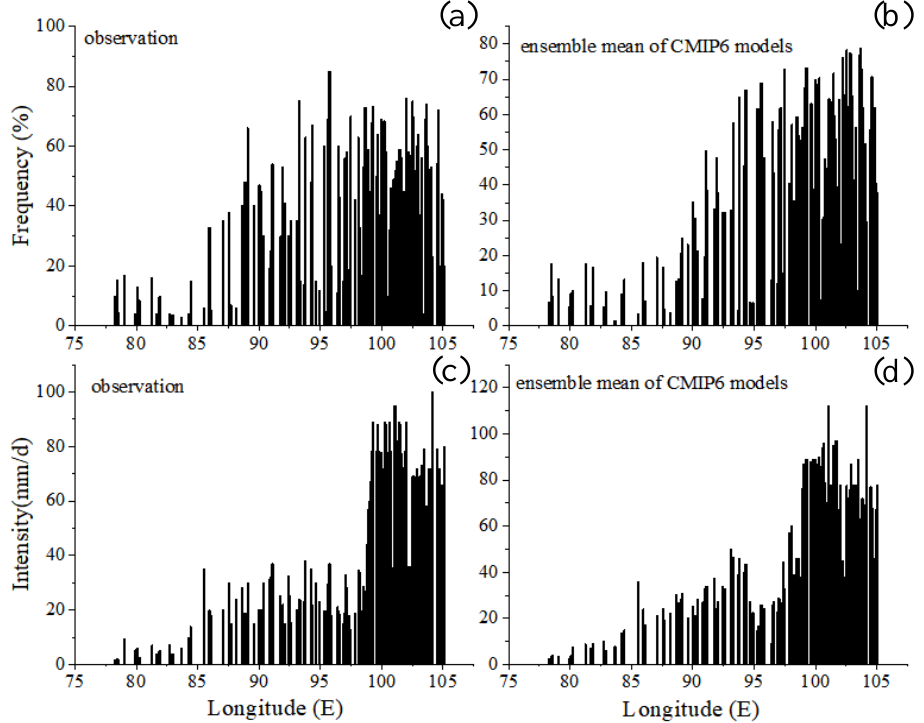
Figure 8. Precipitation frequency ( a ): station observation record; ( b ): the ensemble mean of CMIP6 models with the same weights) distribution and intensity over the TP ( c ): station observation record; ( d ): the ensemble mean of CMIP6 models with the same weights.